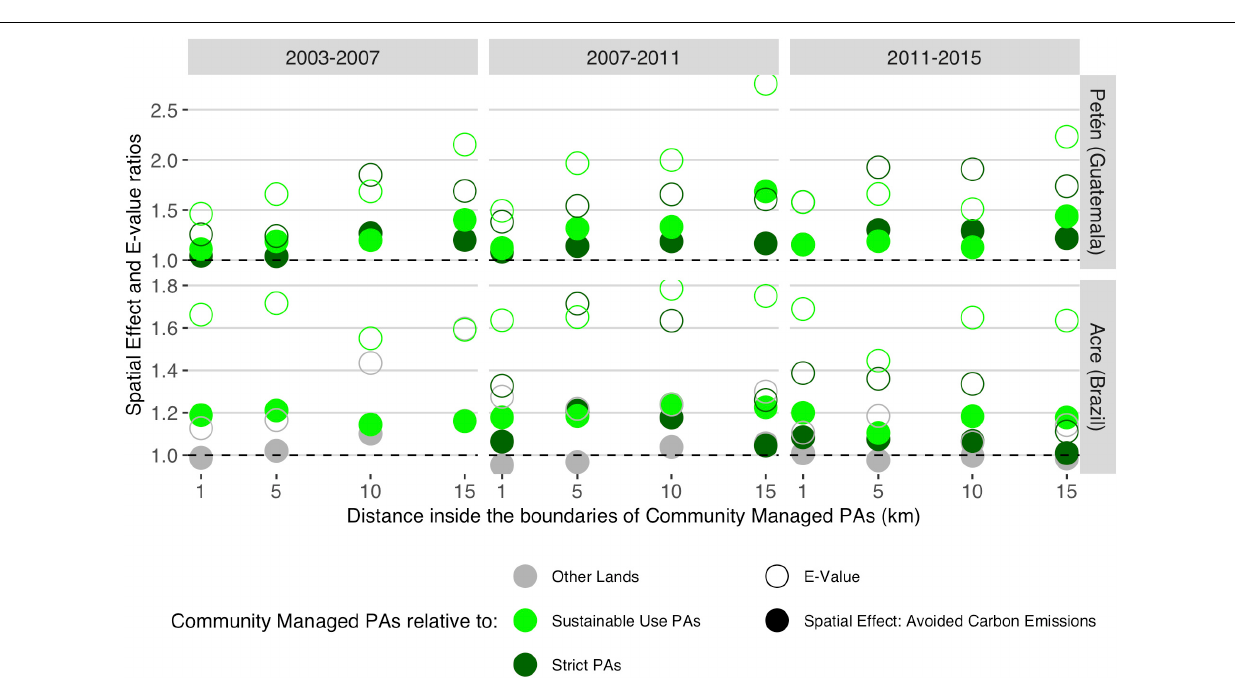
FIGURE 10 | Sensitivity analysis in the spatial effects of Community Managed PAs on avoided carbon emissions in Petén (Guatemala) and Acre (Brazil). The spatial effect ratio (unitless) is equivalent to the probability of a positive spatial effect in the treatment (i.e., Community Managed PAs) divided by the probability of a positive spatial effect in the controls (i.e., Other Lands, Sustainable Use PAs, and Strict PAs). The E -value represents the minimum strength that an unmeasured covariate would need to have with the treatment and the spatial effect for the treatments and spatial effect association not to be